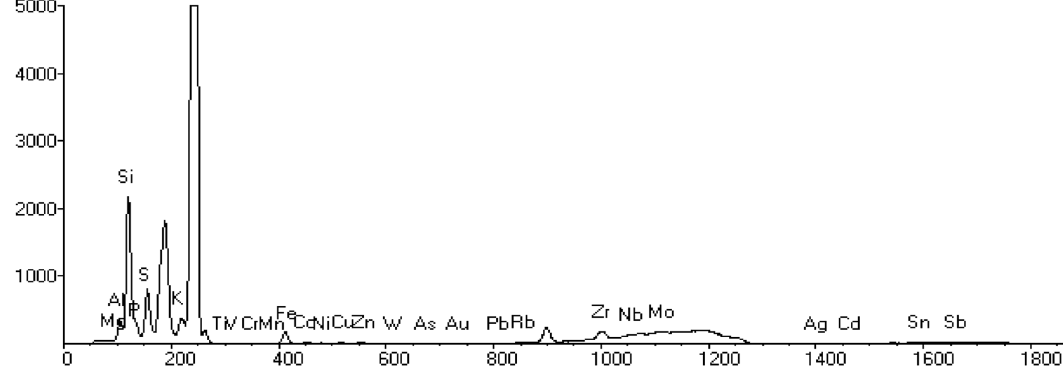
Fig. 2. XRF peaks for PU foam with